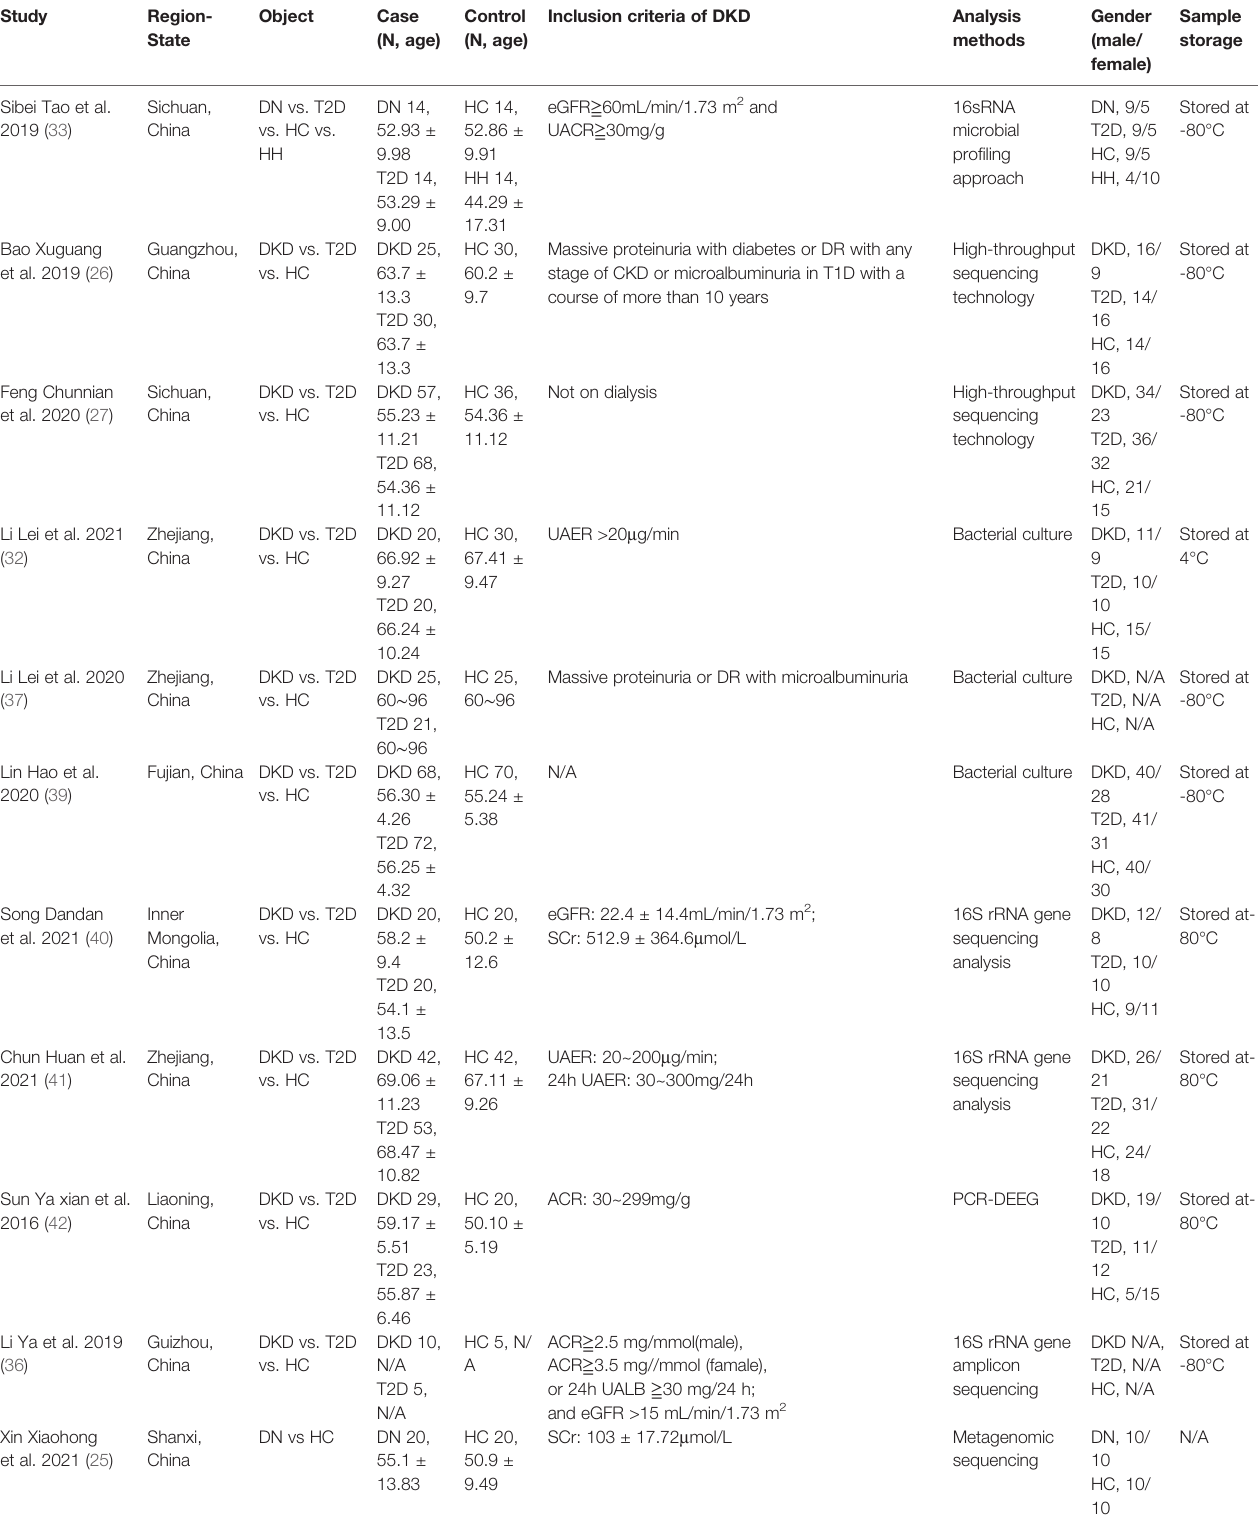
TABLE 1 | Characteristics of the included